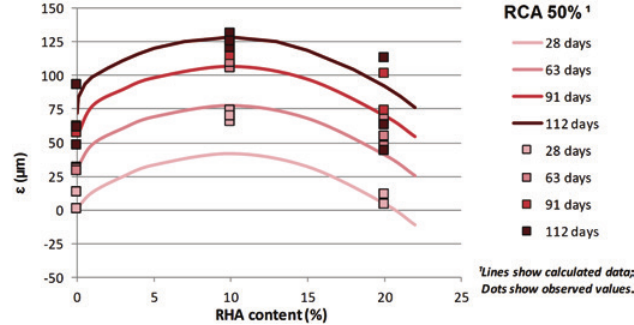
Shrinkage test, replacement with RHA with 25% RCA for mixtures of different